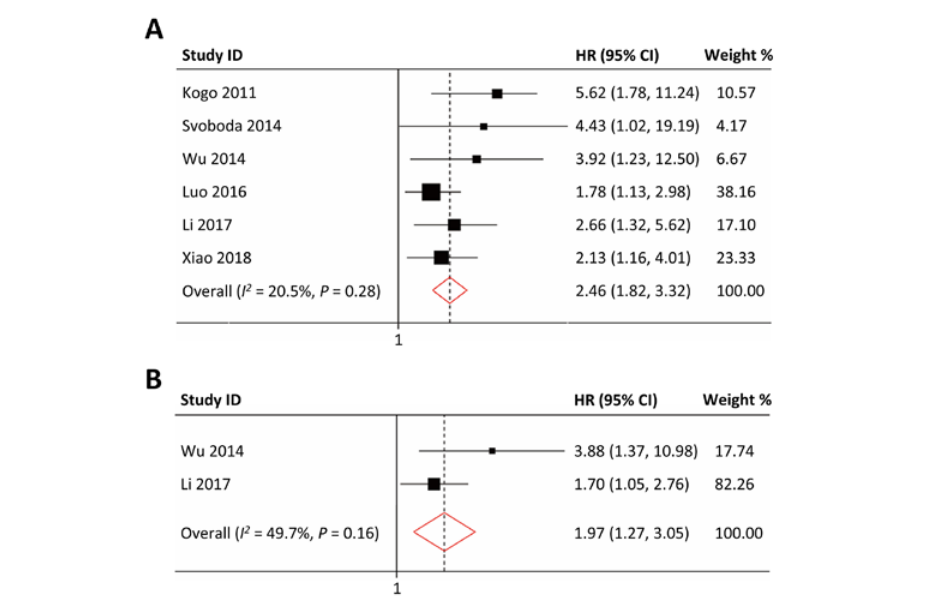
Figure 2: The forest plot between HOTAIR expression and survival outcome in colorectal cancer. (A) HOTAIR and overall survival. (B) HOTAIR and relapse-free